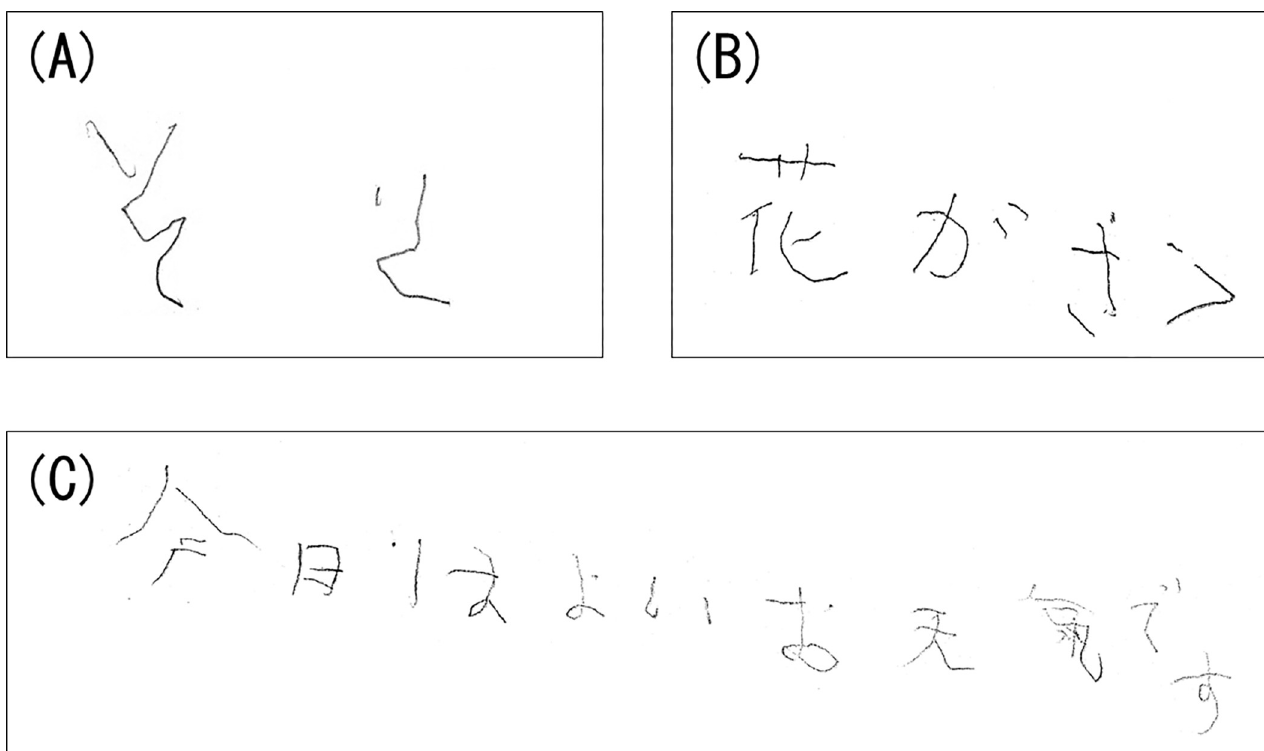
Fig 1. Example of mirror writing in a PD patient. (A)Task: Writing the word, “ そら ”. “ ら ” was reversed. (B) Task: Writing the sentence, “ 花がさく ”. “ く ” was reversed. (C) Task: Writing the sentence, “ 今日はよいお天気です ”. “ 今 ” was reversed.